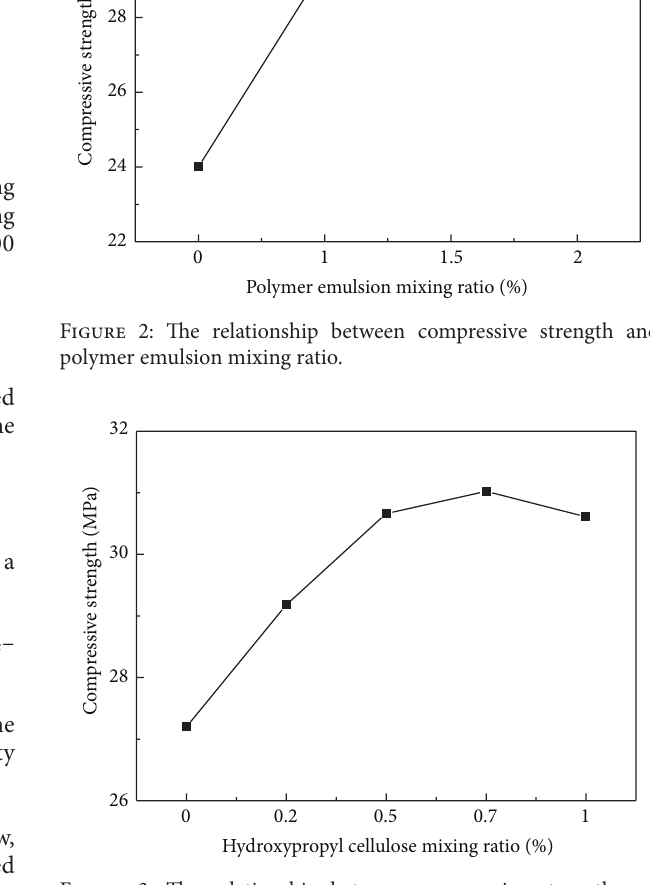
Figure 3: The relationship between compressive strength and hydroxypropyl cellulose mixing